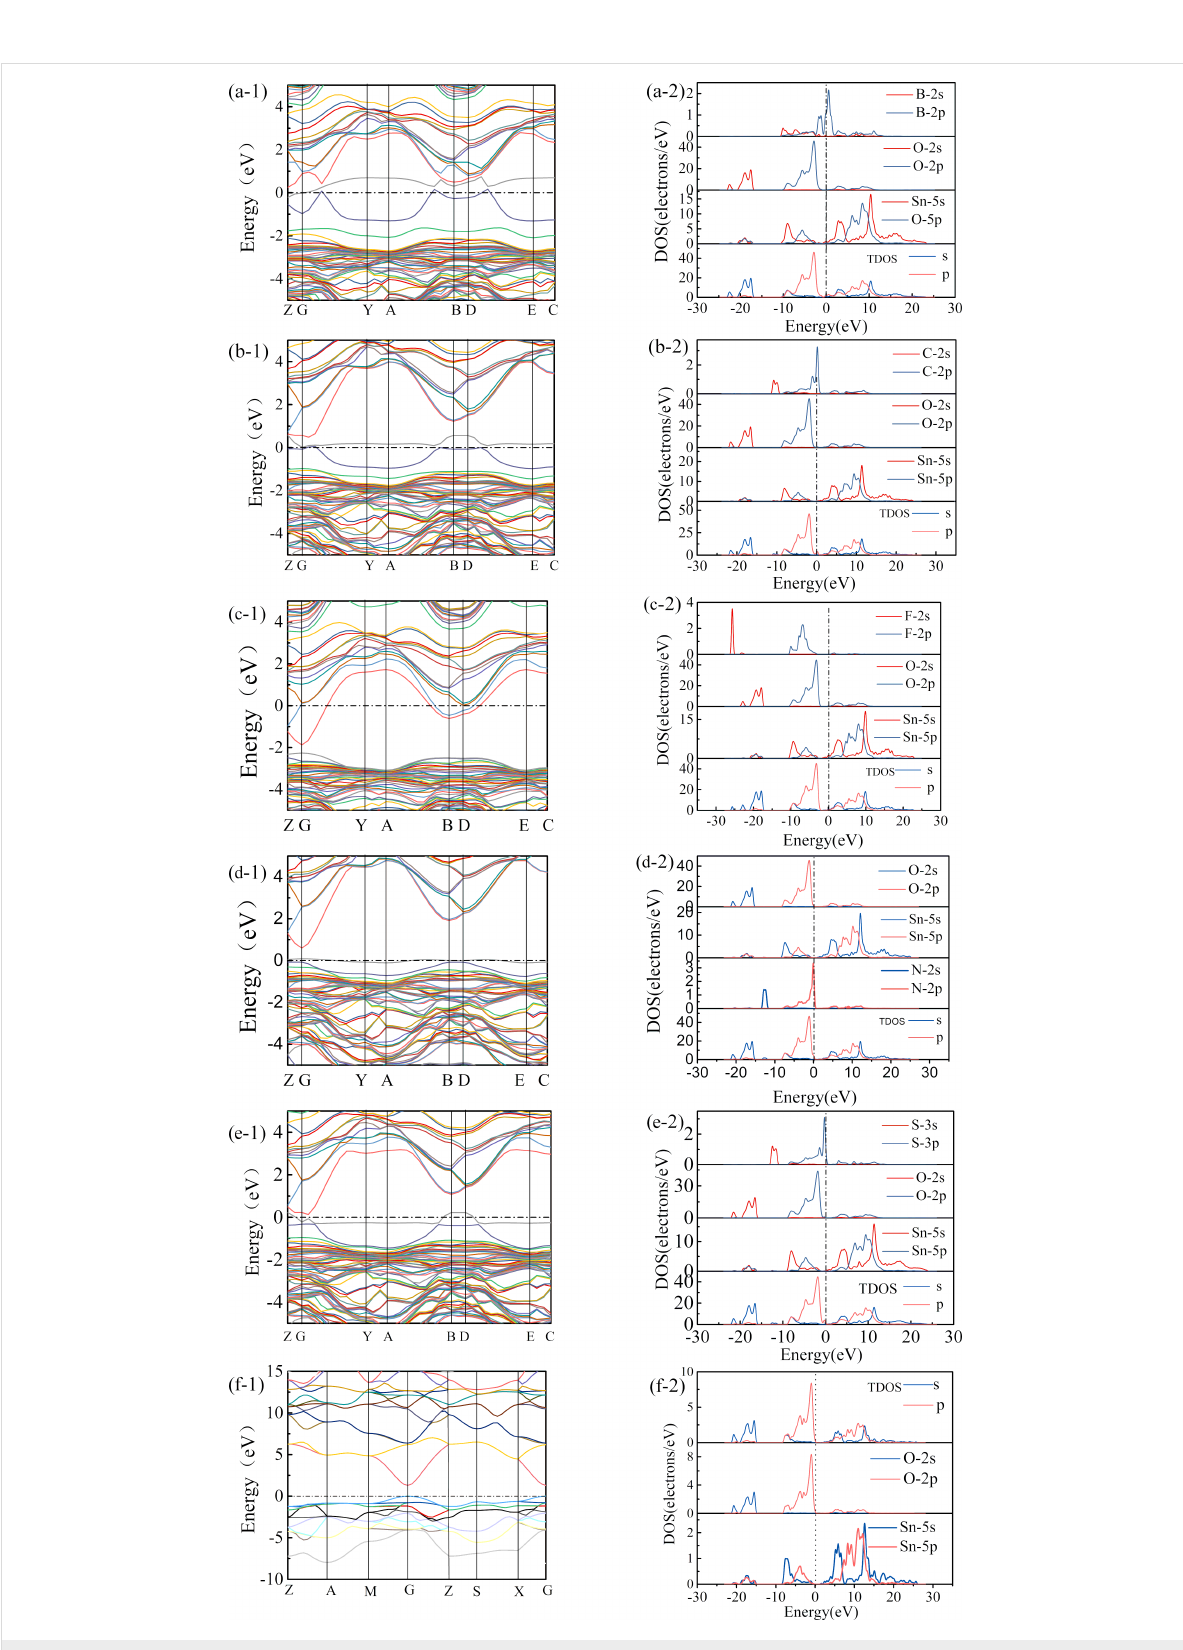
Figure 2: Energy band structure, total density of states and partial density of states of SnO 2 doped with non-metal atoms: (a) SnO 2 /B, (b) SnO 2 /C, (c) SnO 2 /F, (d) SnO 2 /N, (e) SnO 2 /S, (f) SnO 2